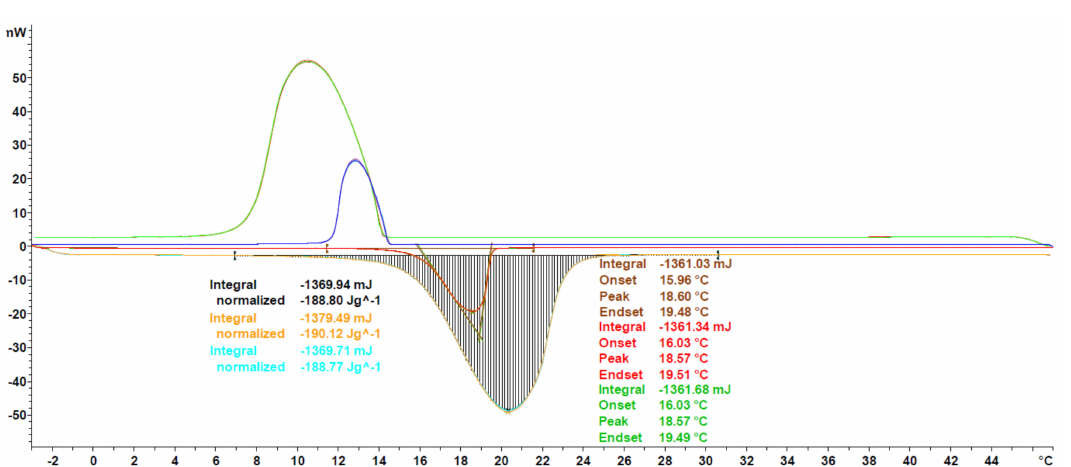
Figure 7. Heat flux curve of Crodatherm17 for a single experiment. Heating (lower) and cooling (upper) segments are shown, though only heating segments are evaluated for enthalpy and onset, peak and endset temperatures, as described in Section